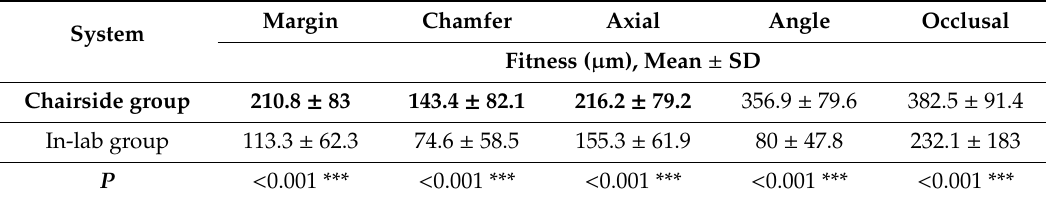
Figure 6. Comparison of the marginal and internal fit mean values by digital workflows. ***, Significant ( p < 0.001).